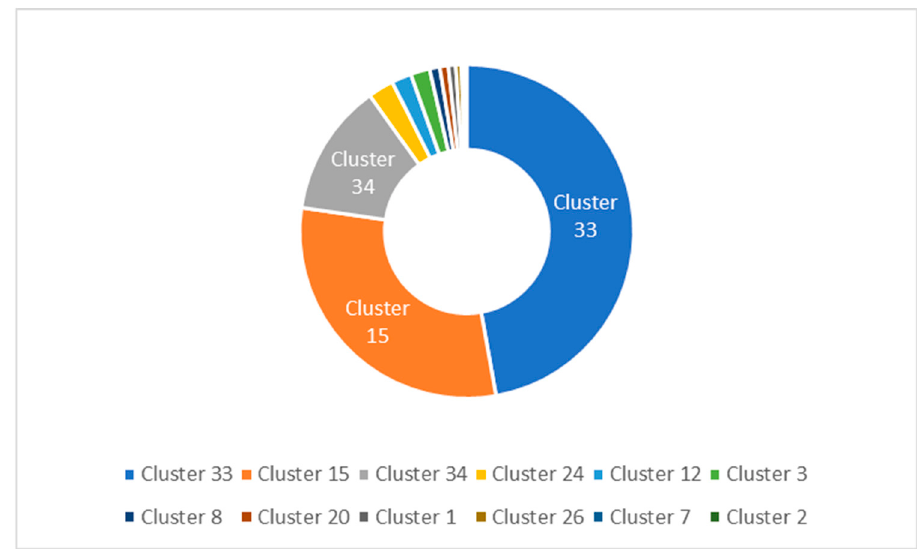
Figure 7. Partial view of the distribution of elements by cluster.